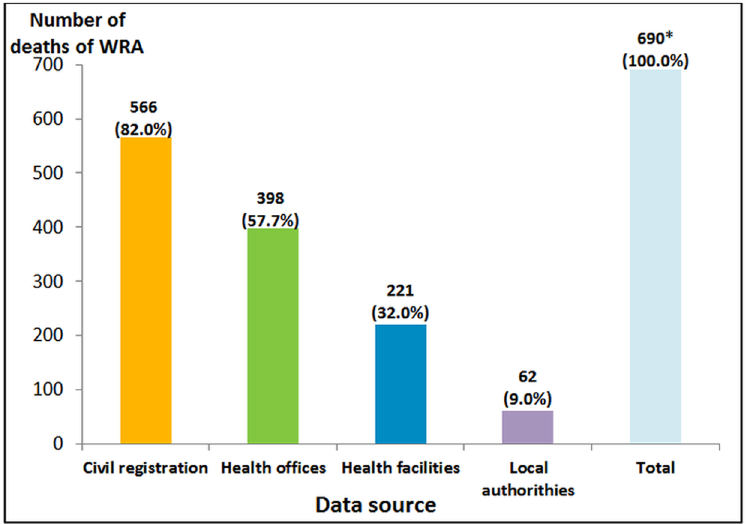
Fig 1. Deaths among WRA identified by data source (N = 690). (cid:3) One death not recorded by data source in GCBH but identified through verbal autopsies in Sidi Kacem. It was a woman resident in GCBH but who died outside of the region thus not recorded in any of the four data sources